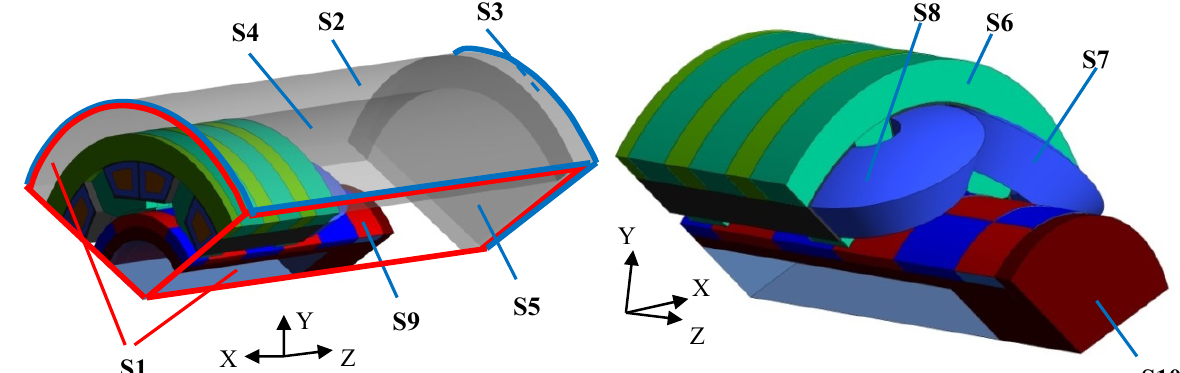
Figure 6. Boundary of the TFPMLM temperature field model: S2 : outer surface of casing; S3 : outer surface of end cap; S4 : inner surface of casing; S5 : inner surface of end cap, S6 : outer surface of stator core in end region; S7 : vertical outer surface of end winding; S8 : horizontal outer surface of end winding; S9 : outer surface of PMs; and S10 : outer surface of mover.